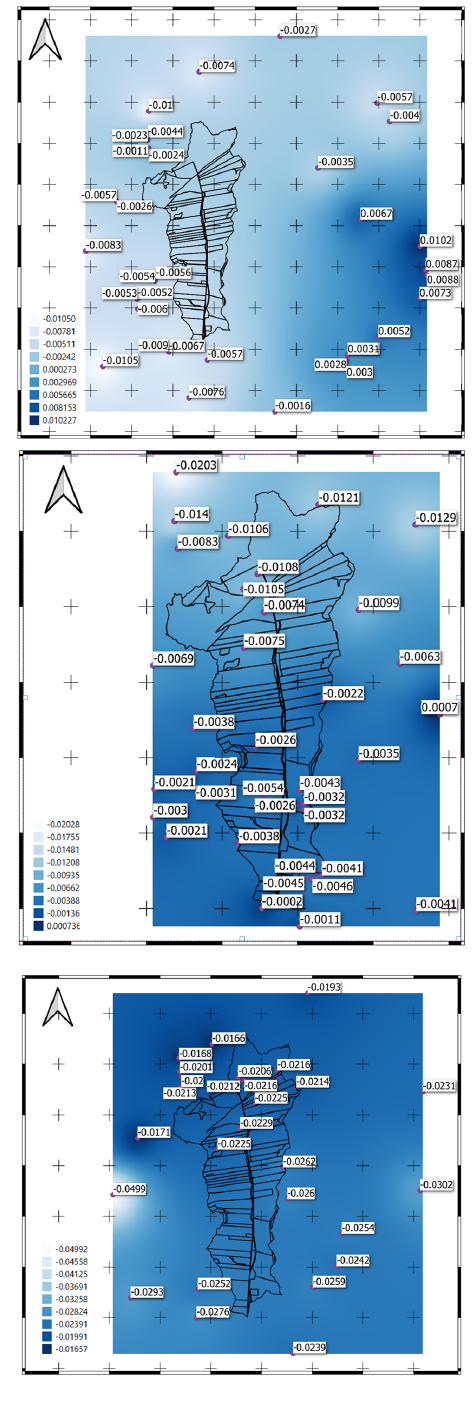
Figure 7. Matching deformation values to high-coherence points and its interpolation. Zebra frame segments of 1 km. Table 3 shows the total deformation range inside the basin—that is, the difference between the maximum positive and negative deformations—and the mean deformations inside the basin (with the standard deviation) for scenarios AW-1 to AW-3.